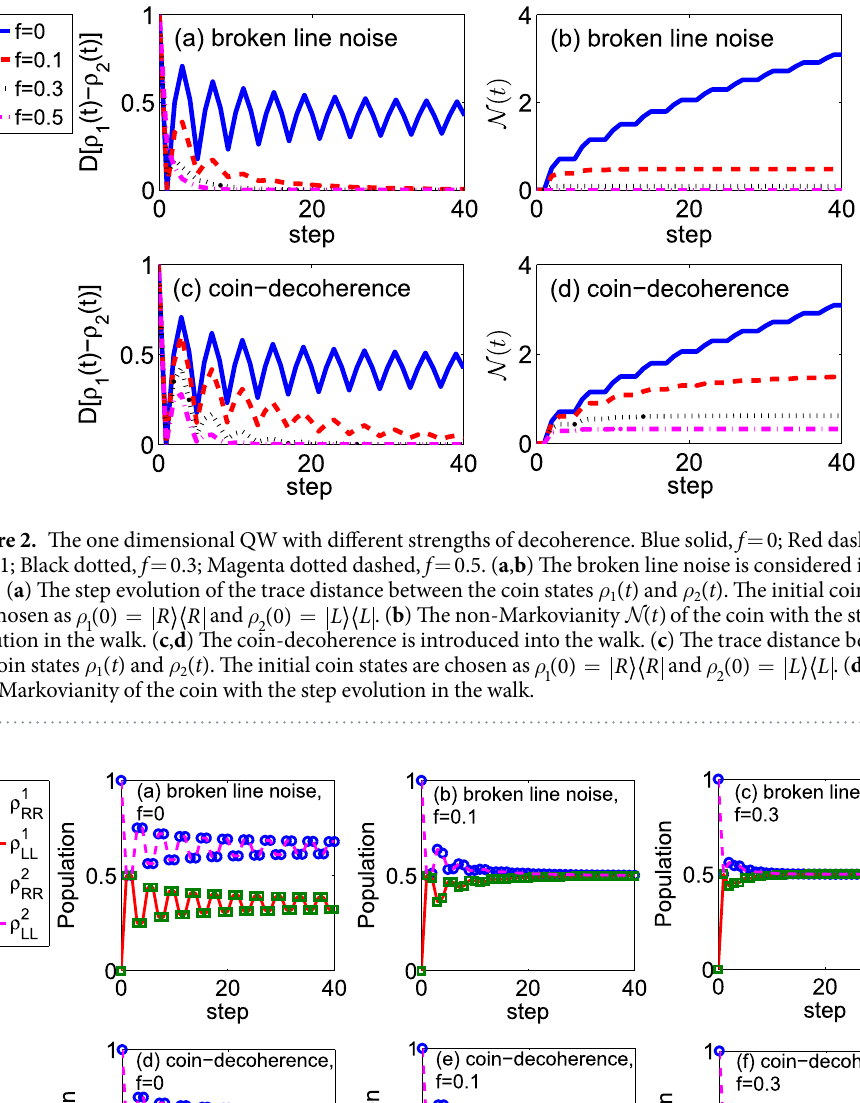
Fig. 3(a–c), the broken line noise emerges in the walk. For Fig. 3(d–f), the coin-decoherence appears in the walk. Different strengths of noise are addressed. When the strength of decoherence satisfies f = 0 (see Fig. 3(a,d)), which means there is no noise in the walk, the populations of coin at the state | R 〉 and | L 〉 are not same. While, when any one noise emerges in the walk (see Fig. 3(b,c,e,f)), with the increase of the step, the populations of the coin at the state | R 〉 and | L 〉 are nearly equal. Such results have been obtained from our aforementioned discussion. Furthermore, considering the two initial coin states here (| R 〉 and | L 〉 ) are same as that used in the description of the non-Markovianity  t ( ) (Fig. 2), we find that when the strength of decoherence increases, the amplitudes of oscillations for the populations of the coin reduce. For the oscillations of the populations are directly related to the increase of trace distance ρ can be found